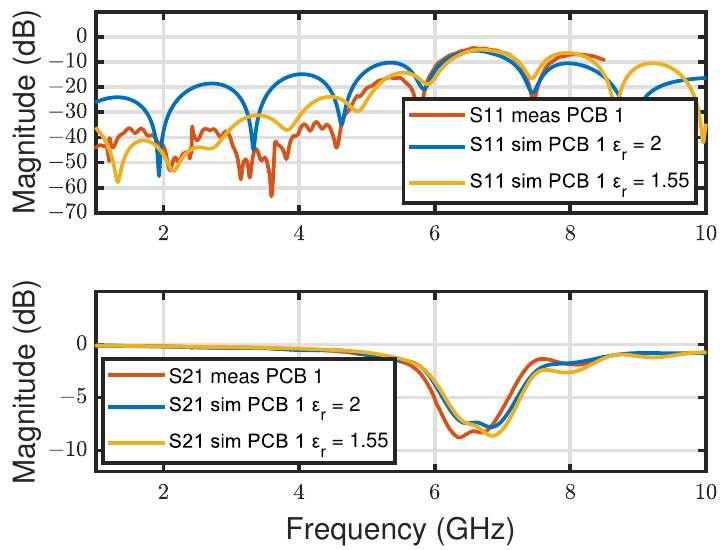
Figure 4. Investigation of insertion and transmission losses for various values of ε r for PTFE applied to the SMA connector